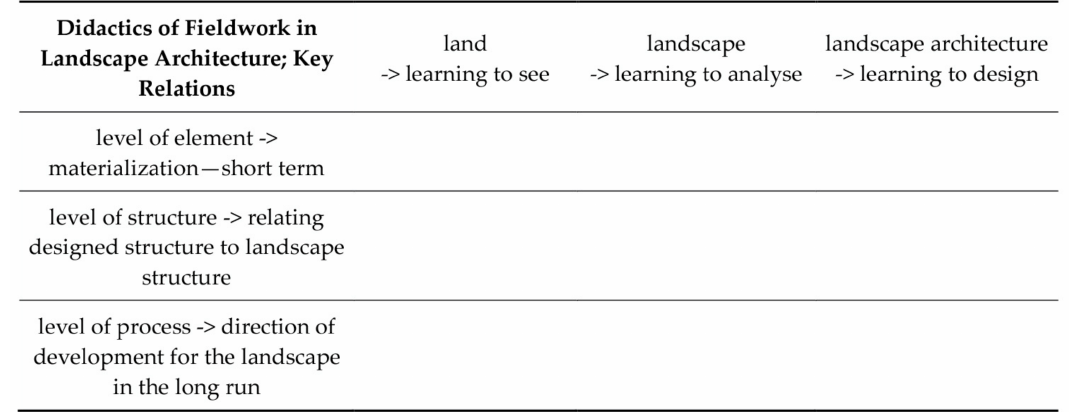
Figure 4. Didactics of fieldwork is first of all based on the distinction between different levels in sites, landscapes, and projects at different levels of intervention